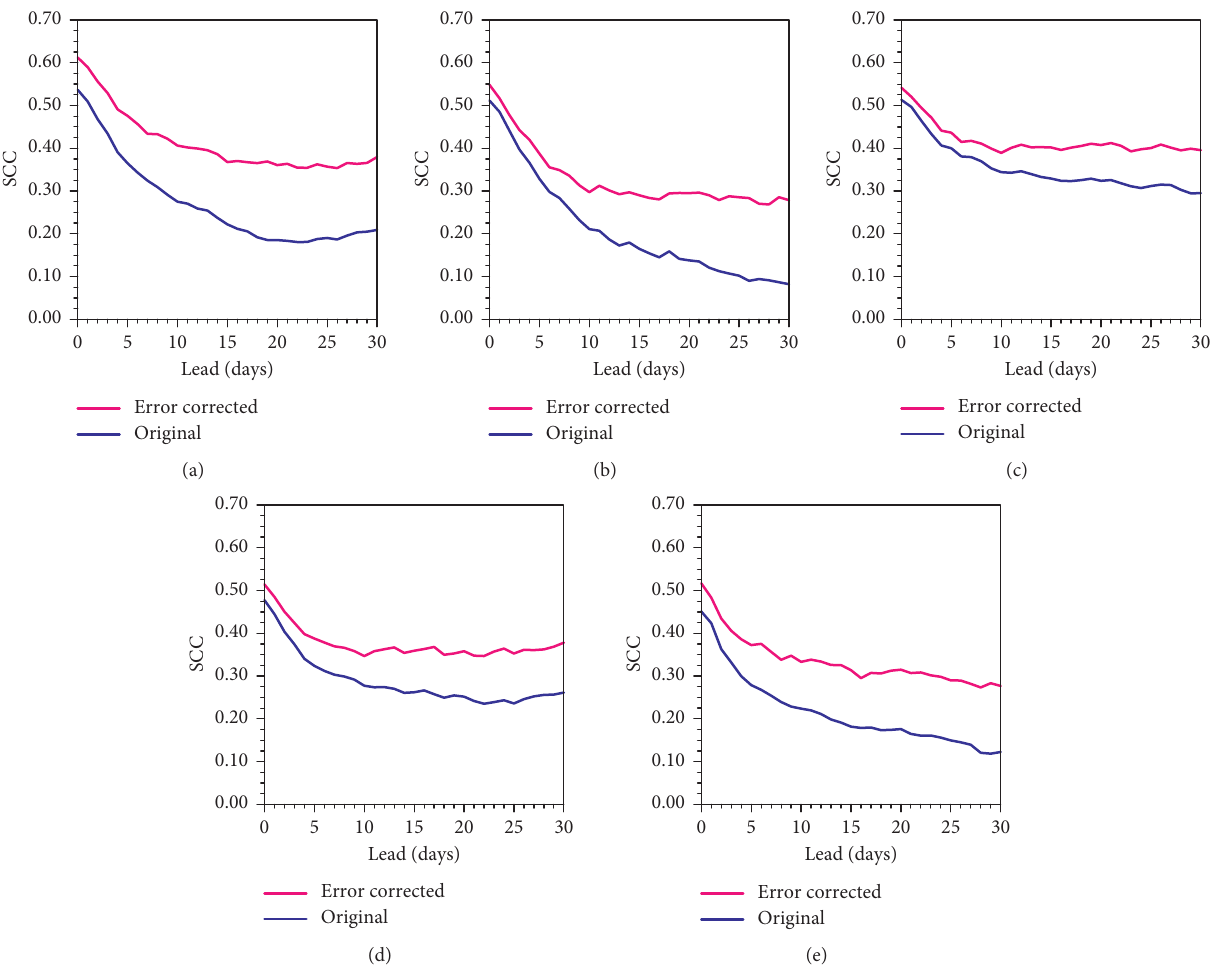
Figure 10: As in Figure 8, but for SCC. (a) Reg1, (b) Reg2, (c) Reg3, (d) Reg4, and (e)